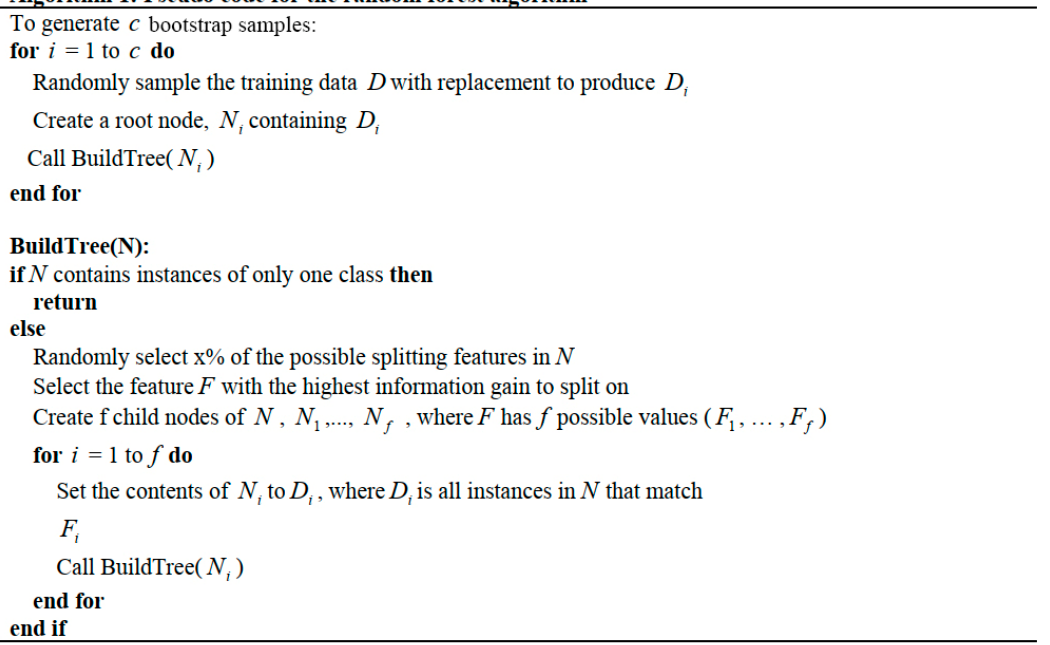
Figure 1. Random forest’s (RF) pseudo-code [40].